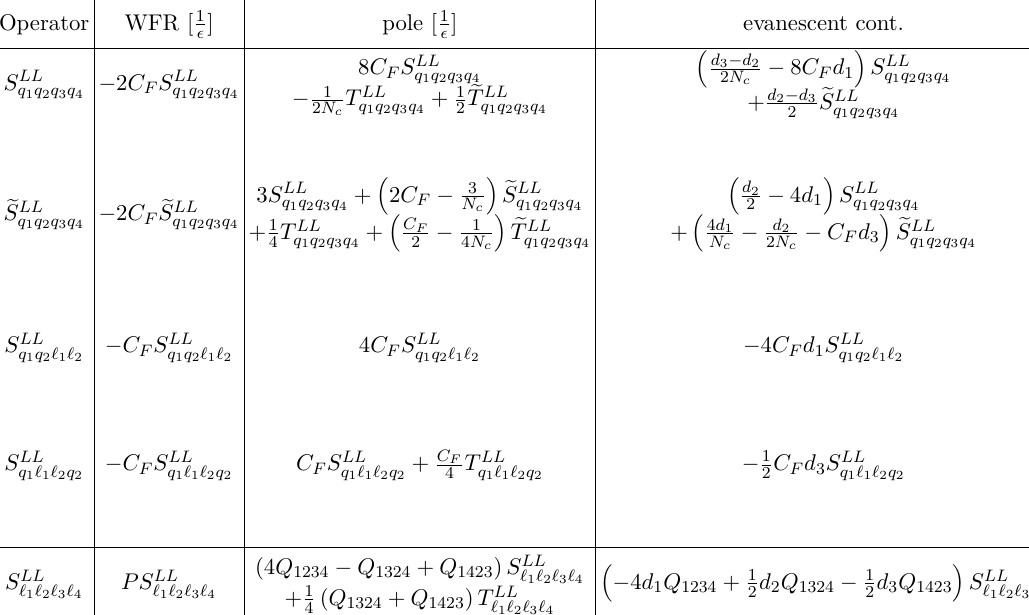
Table 13. Loop structure for P L ⊗ P L operators: the columns correspond to the divergent WFR contributions and vertex corrections as well as the finite contributions from evanescent operators, computed in the generalised BMU scheme. The first four rows result from QCD and are given in units of α s / (4 π ) whereas the last one is a QED correction given in units of α/ (4 π )